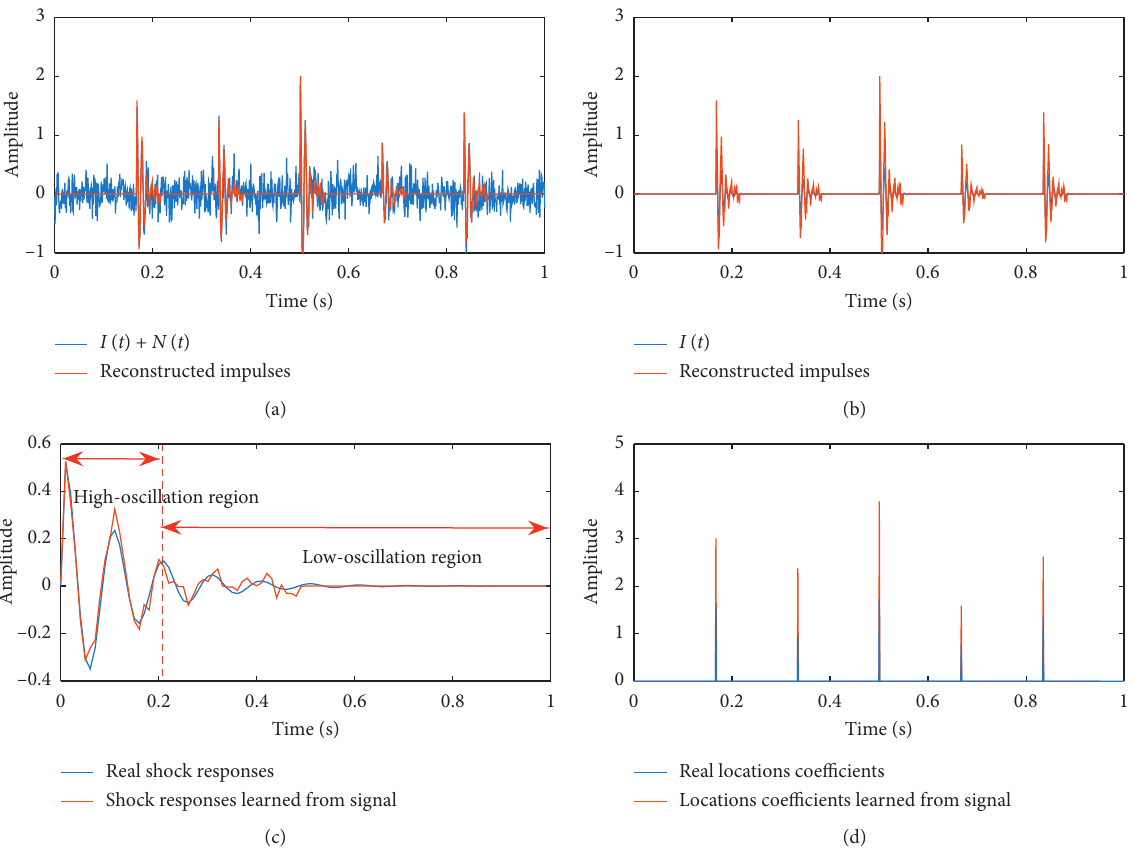
Figure 3: The result of UC-DLA processing signal x ( t ) . (a) Impulses obtained by convolution sparse reconstruction; (b) comparison of reconstructed impulses and real impulses; (c) shock responses learned from signal; and (d) location coefficients obtained from signals.